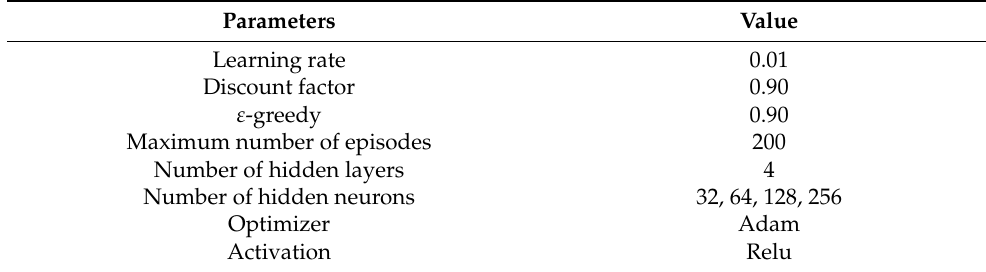
Table 1. Parameters of DDQN in Tensorflow platform.